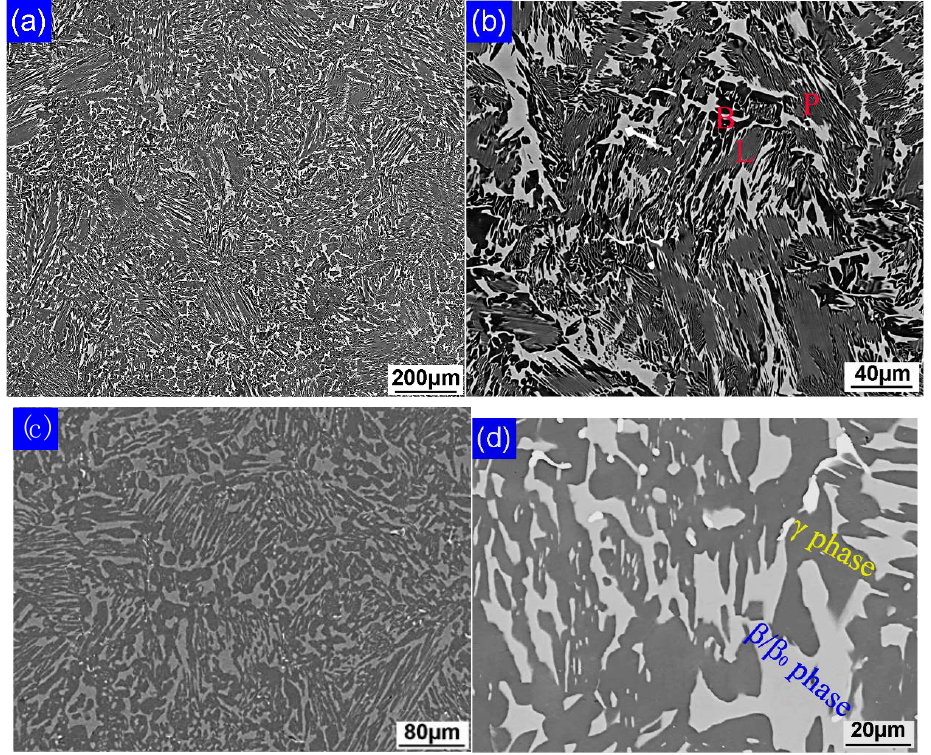
Figure 3. The microstructure of Ti-44Al-4Nb-4V-0.3Mo-Y alloy: ( a , b ) are the as-cast condition; ( c , d ) are the microstructure after annealing at 950 °C for 48 h.